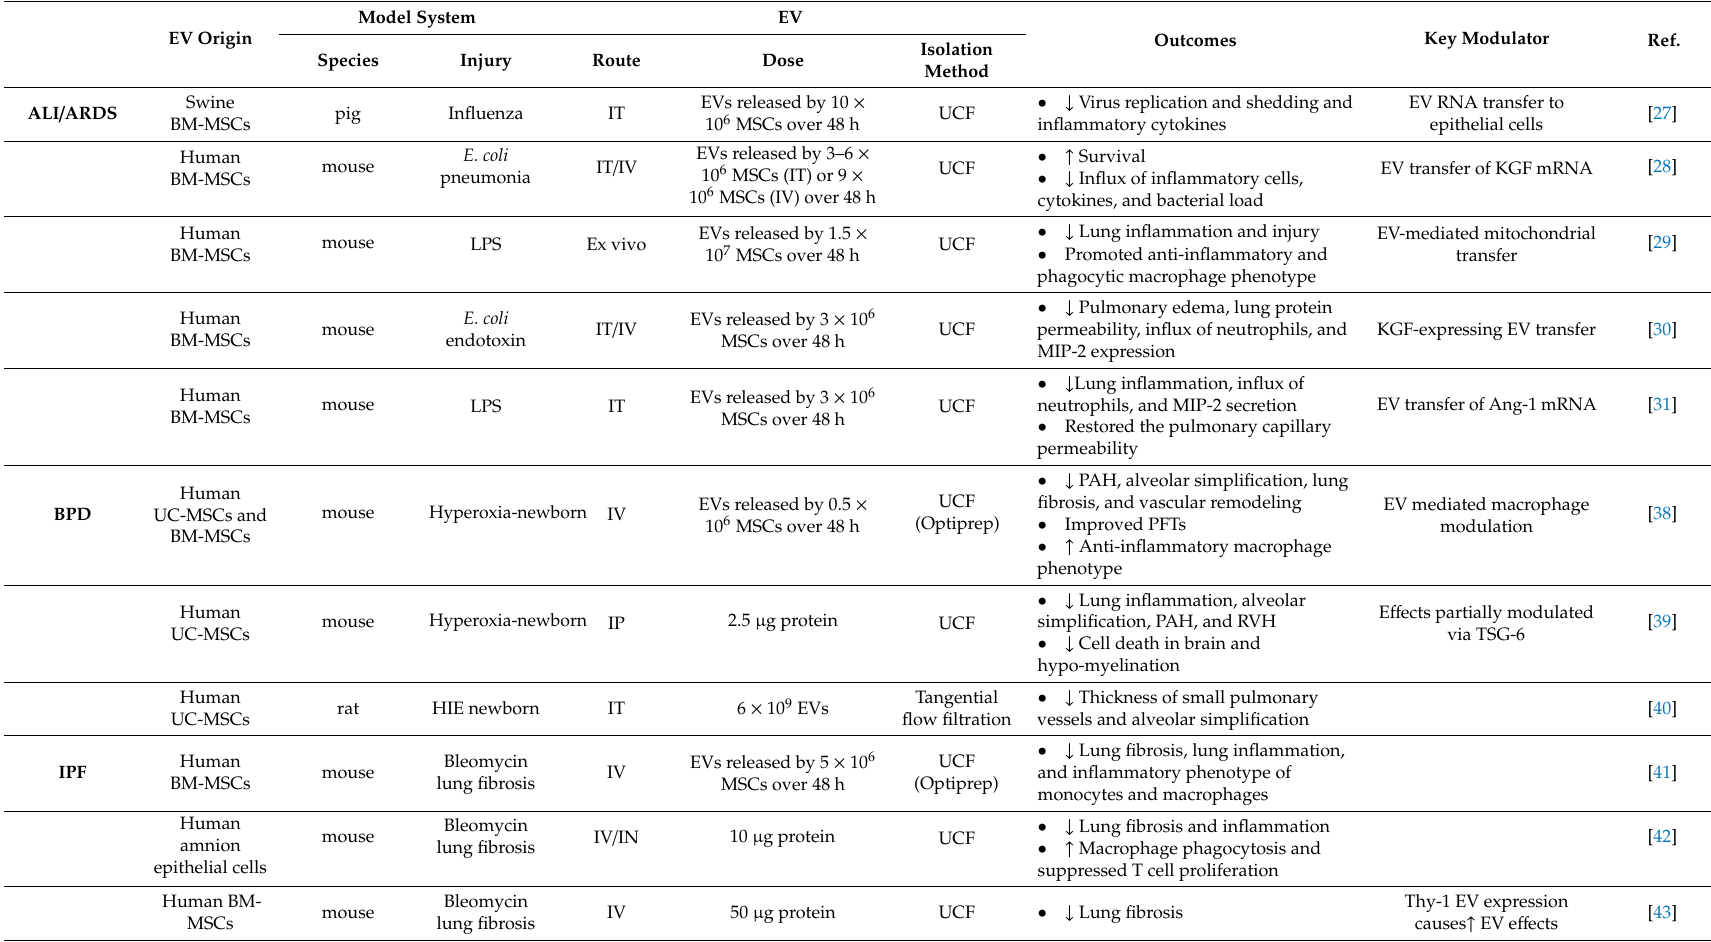
Table 1. EV treatment in preclinical models of lung